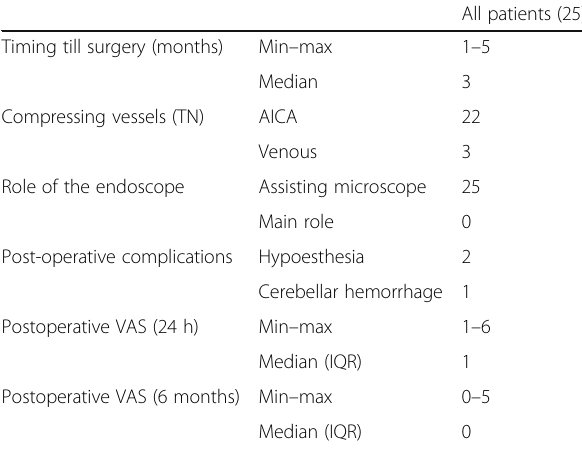
Table 3 Operative data of patients underwent MVD for treatment of HFS Offending vessel (HFS)